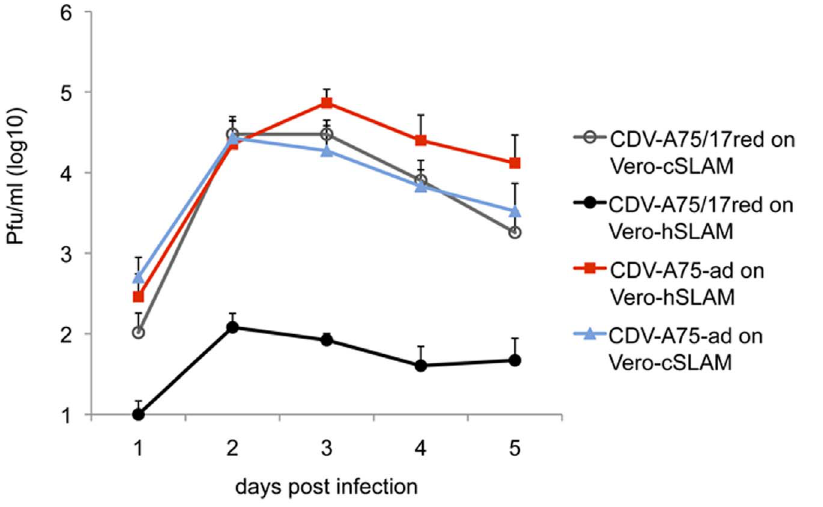
Figure 4. Comparison of single step growth curves of parental and adapted CDV-A75/17 red using canine and human CD150- expressing target cells. Vero-cSLAM cells (open circles) and Vero-hSLAM cells (closed circles) were infected with parental CDV-A75/17 red , and Vero- cSLAM cells (blue triangles) and Vero-hSLAM cells (red squares) were infected with human CD150-adapted CDV-A75/17 red (CDV-A75-ad) at a MOI of 0.01 and incubated for indicated times before harvesting cell bound plus released virus. The viruses were then titrated using the optimal target cells for each virus (n=3, using 3 independently adapted viruses).